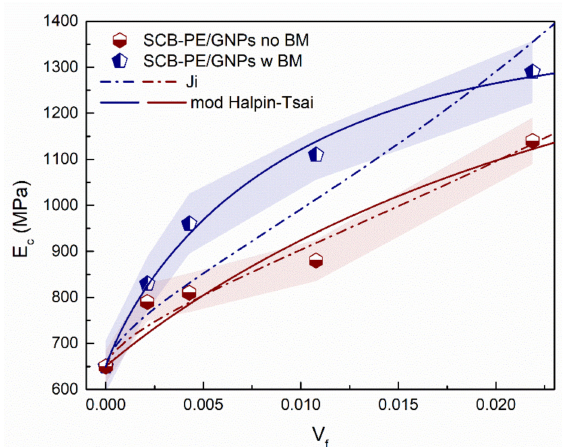
Figure 2. Theoretical modeling of elastic modulus for the SCB-PE/GNPs no BM and SCB-PE/GNPs w BM nanocomposites’ experimental data as a function of filler volume fraction, using the Ji and modified Halpin-Tsai